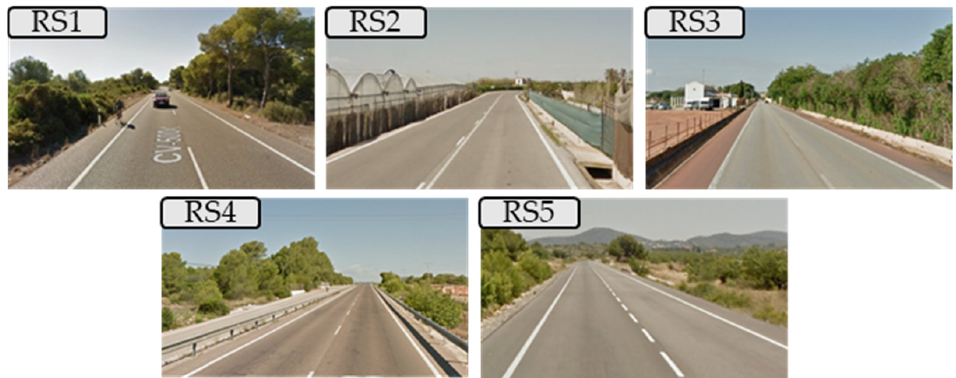
Figure 1. Cross section of the five two-lane rural roads where the study was developed.